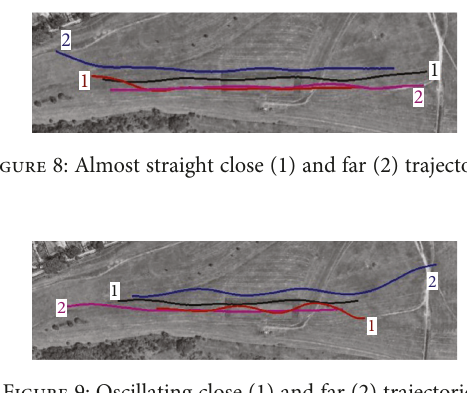
Figure 9: Oscillating close (1) and far (2)